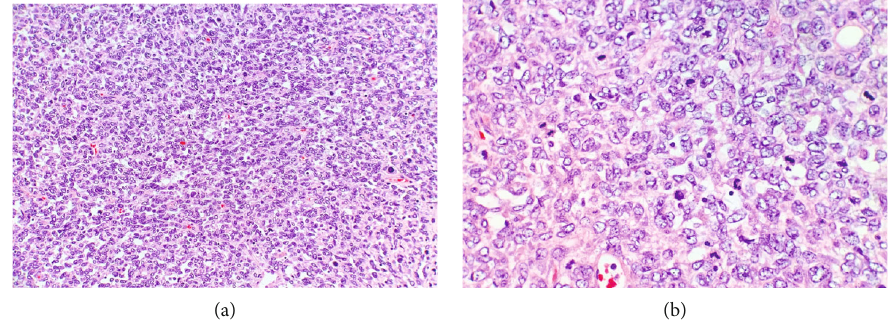
Figure 4: Malignant phyllodes tumor. (a, b) There is marked nuclear pleomorphism and mitotic activity (H&E, × 200 (a), × 400 (b)).